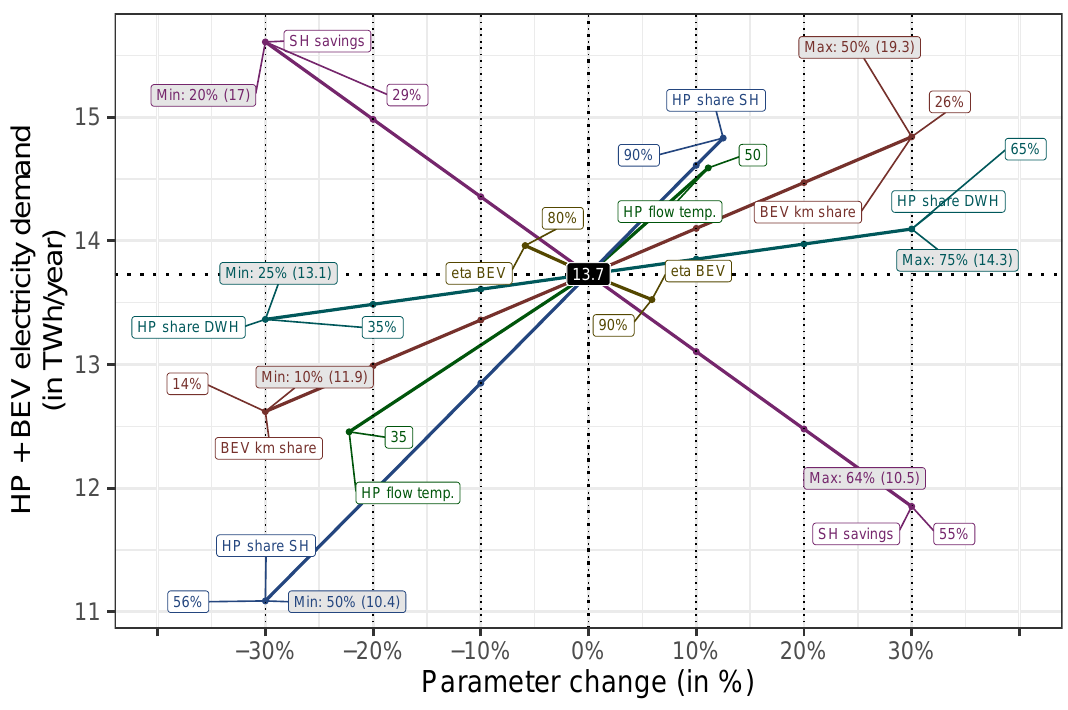
Figure 13. Sensitivity plot of the additional total electricity demand of heat pumps and BEV with respect to plausible percentage changes of the key parameters in Table